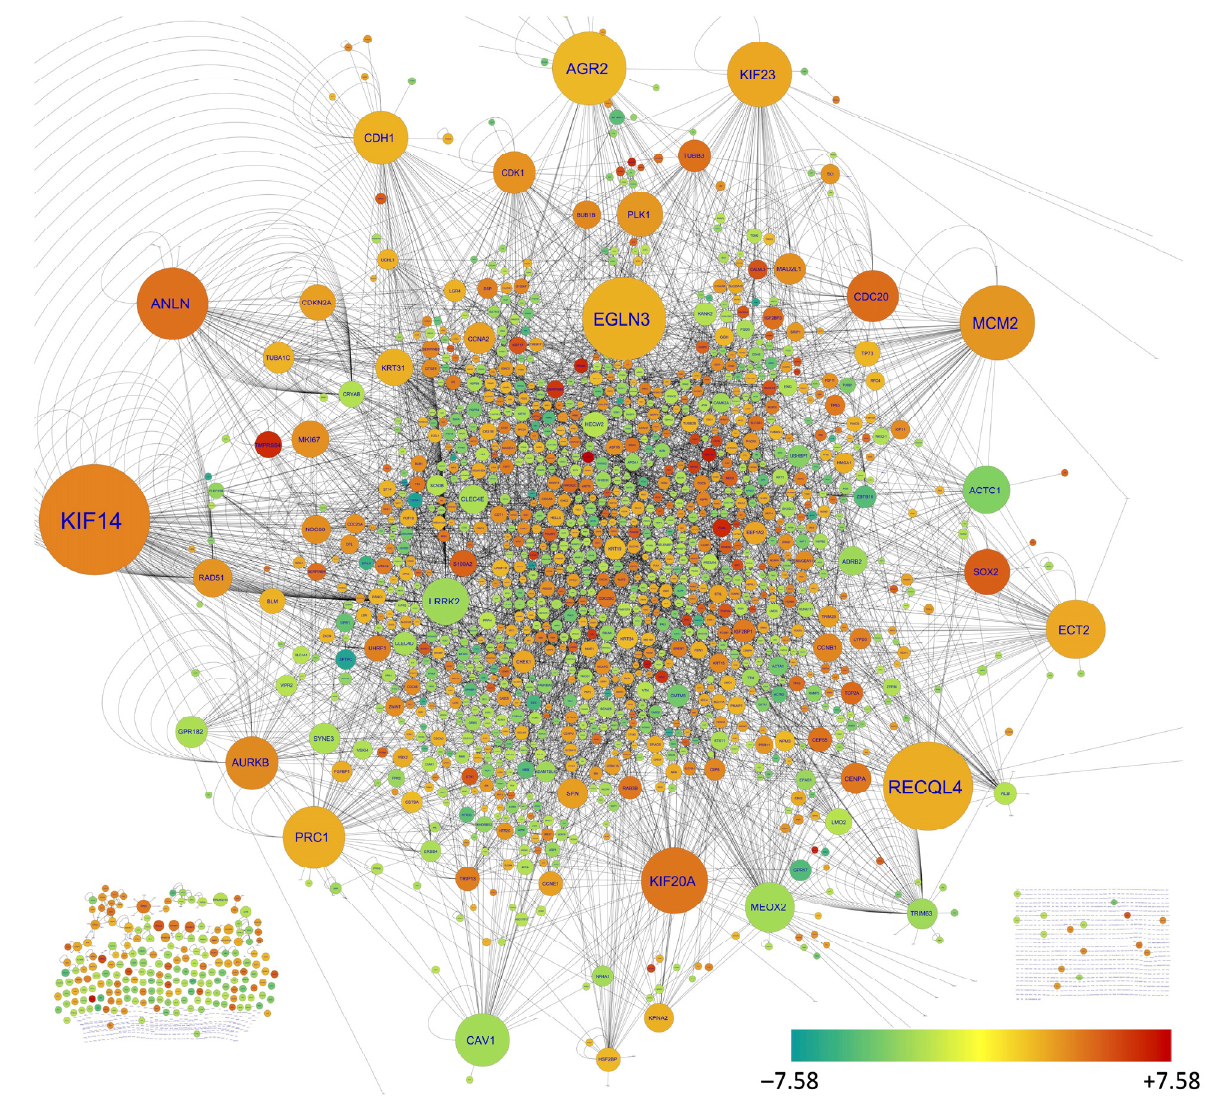
Figure 2. Biological interaction network of DEGs identified in NSCLC samples according to BioGRID v 4.4.205. The DEGs’ nodes were filtered from all interactions available in BioGRID. The node sizes are arranged as per their degree in the original human interaction network and therefore indicate their central involvement in human cellular interactions. The colors of the nodes were determined by their log2FC value, where green to red represents negative to positive log2FC values.